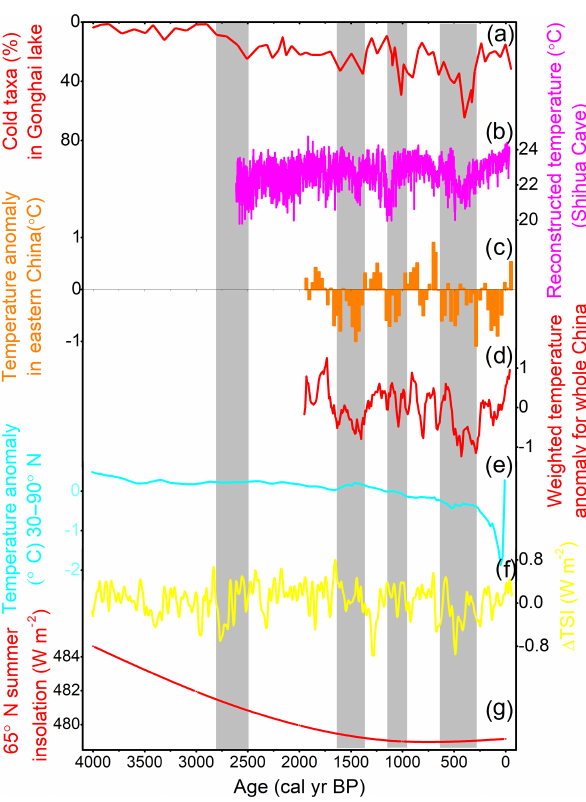
Figure 6. Comparison of (a) cold-preferring taxa percentages in Gonghai Lake with intra-regional temperature records during the past 4000 years, including (b) reconstructed temperature based on stalagmite layer thickness in Shihua Cave (Tan et al., 2003), (c) winter half-year temperature anomalies in eastern China at 30-year resolution (Ge et al., 2003), (d) weighted temperature reconstruc- tion for China obtained by combining multiple paleoclimate proxy records (Yang et al., 2002) and (e) the paleotemperature for 30– 90 ◦ of the Northern Hemisphere (Marcott et al., 2013). The higher values from (a) to (e) represent warmer environments, and vice versa. All the temperature records are compared with (f) a recon- struction of total solar irradiance (Steinhilber et al., 2009) and (g) summer insolation at 65 ◦ N (Berger and Loutre, 1991) during the past 4000 years. Grey shaded areas indicate cold